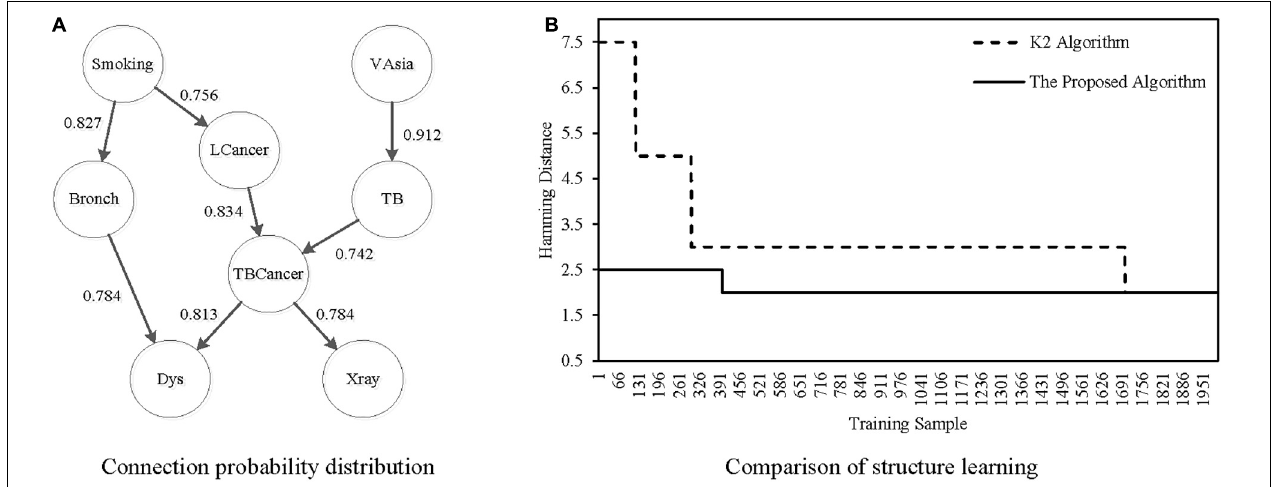
FIGURE 2 | Structure learning of Asia network. (A) Connection probability distribution. (B) Comparison of structure learning.